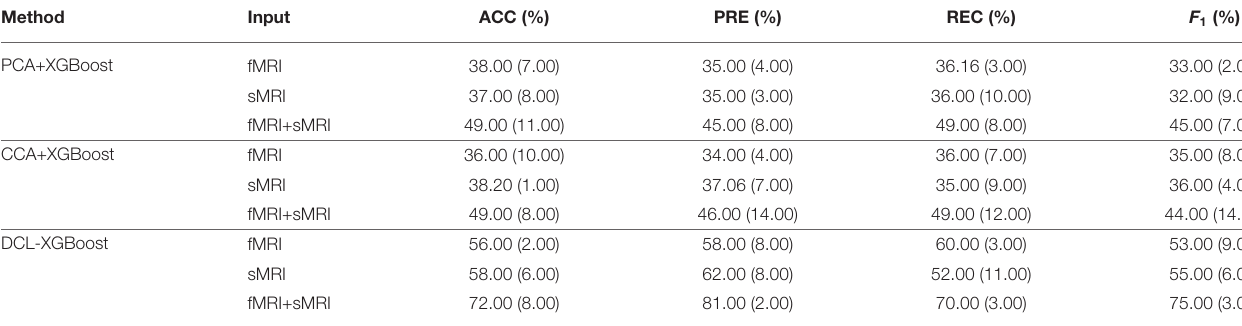
TABLE 4 | Evaluation of different inputs to the different combinations of XGBoost on the CNP dataset.